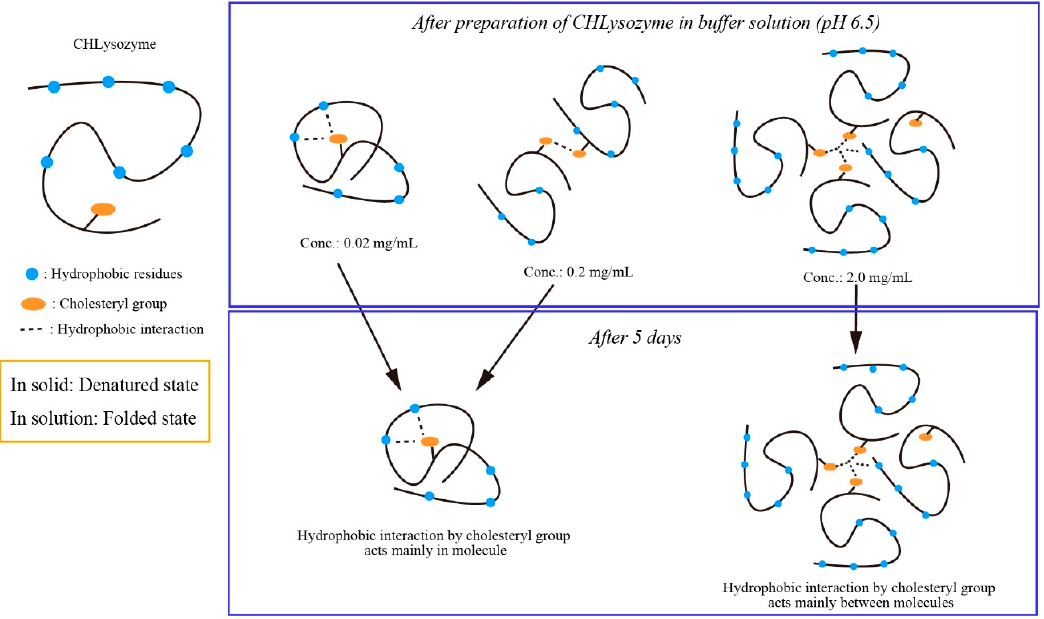
Figure 7. Possible scheme for hydrophobic interaction of CHLysozyme at concentrations tested in the study.